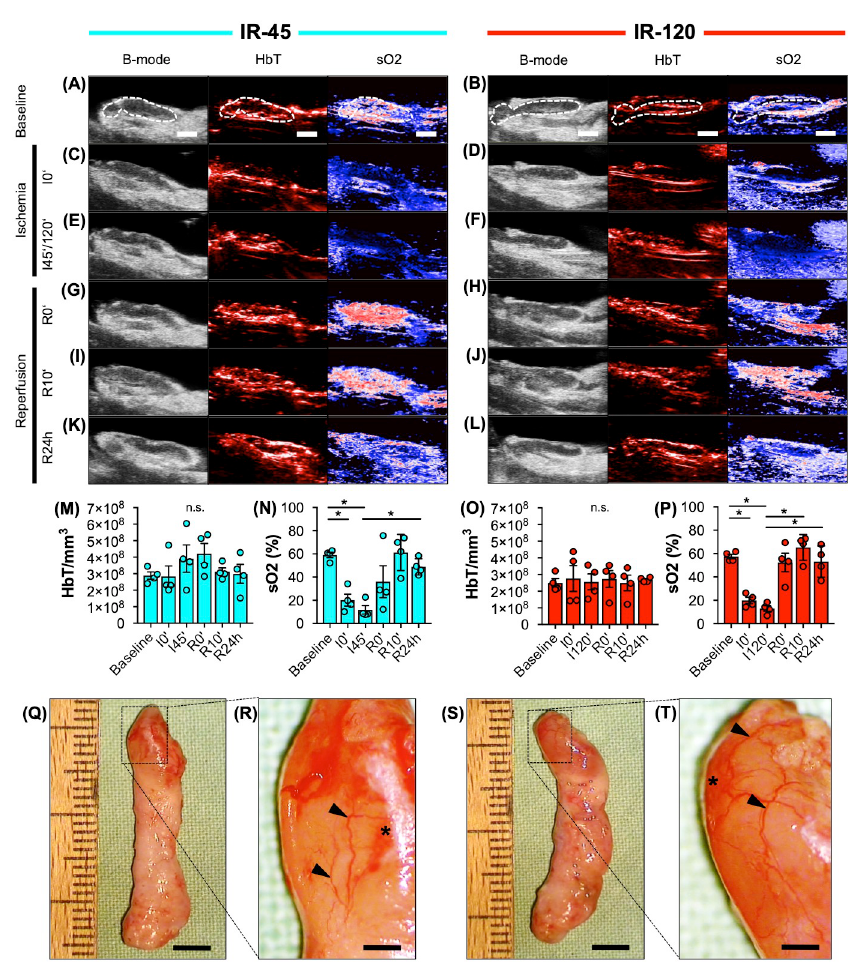
Fig 2. Animal model validation. A-L Ultrasound (B-mode) and photoacoustic (HbT, sO 2 ) imaging of IR-45 and IR- 120 axillary VLN flaps before ( A and B ), during ( C-F ) and after ( G-L ) ischemia (broken line = lymph node). M-P Total hemoglobin (HbT/mm 3 ) and oxygen saturation (sO 2 (%)) of IR-45 ( M and N , cyan) and IR-120 ( O and P , red) lymph nodes at baseline, beginning of ischemia (I0’), after 45 minutes (I45’) or 120 minutes (I120’) of ischemia as well as directly (R0’), 10 minutes (R10’) and 24 hours (R24h) after reperfusion. Mean ± SEM, n = 4, � P < 0.05, n.s. = not significant. Q-T Stereomicroscopic images of IR-45 ( Q and R ) and IR-120 ( S and T ) VLN flaps. Higher magnification ( R and T = inserts of Q and S ) reveals a dilated vascular network (arrowheads) with capsular hemorrhages (asterisks). Scale bars: A-L = 2 mm, Q and S = 4.5 mm, R and T = 900 μ m. IR = ischemia/reperfusion, VLN = vascularized lymph